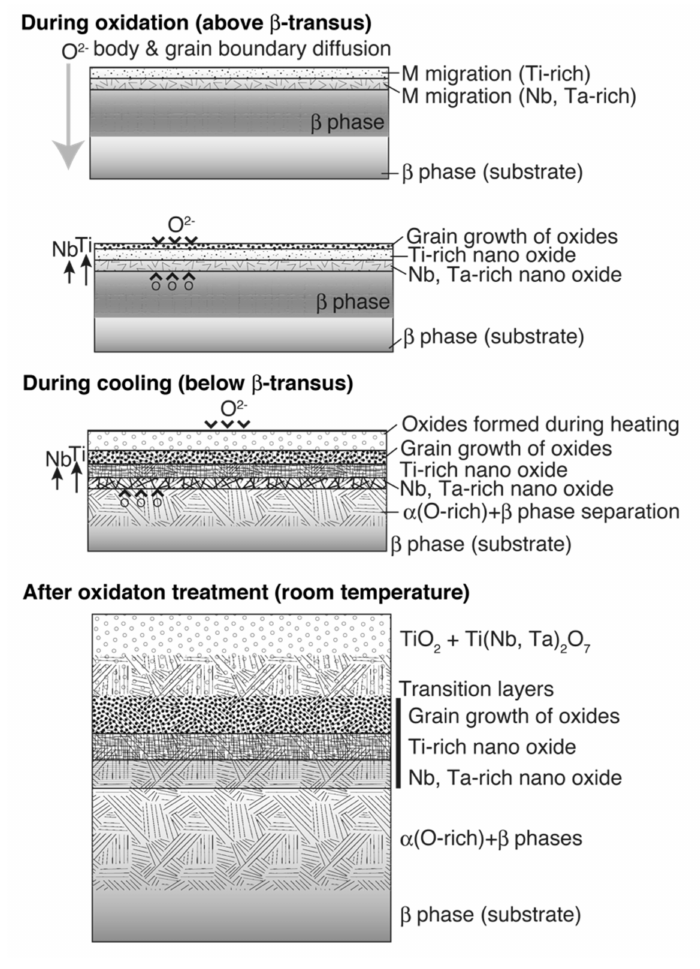
Figure 14. Illustrations of oxidation mechanisms for Ti–29Nb–13Ta–4.6Zr and Ti–36Nb–2Ta–3Zr–0.3O deduced from the obtained